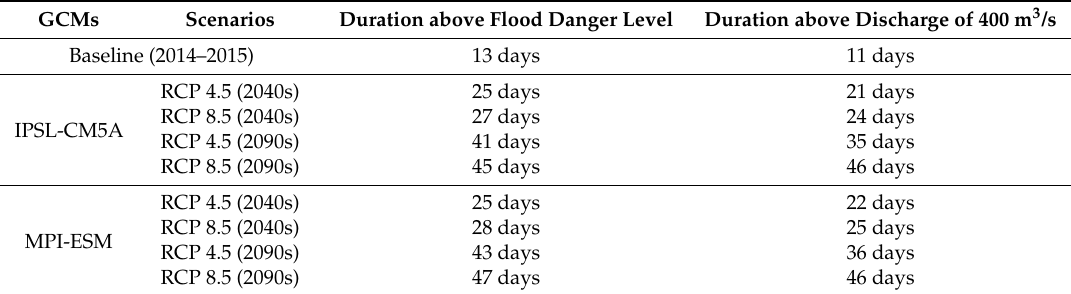
Table 4. Change in duration above the current (2014–2015) flood danger level and extreme discharge at Noapara in the Betna River for two RCPs, two GCMs and two future